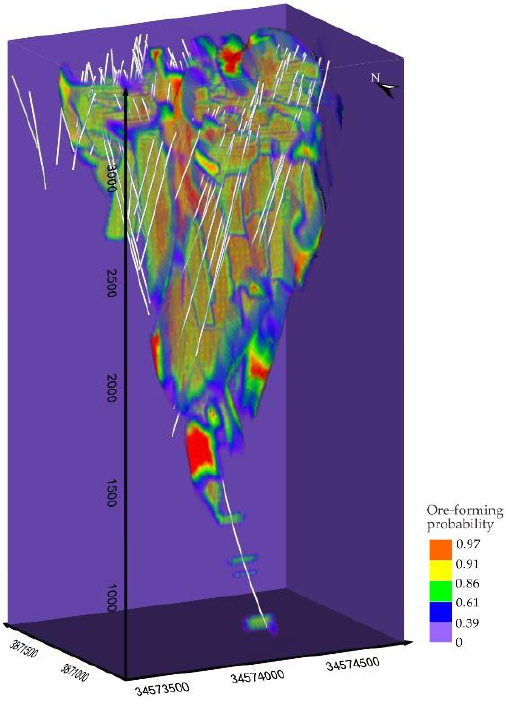
Figure 9. DAE-based 3D MPM.